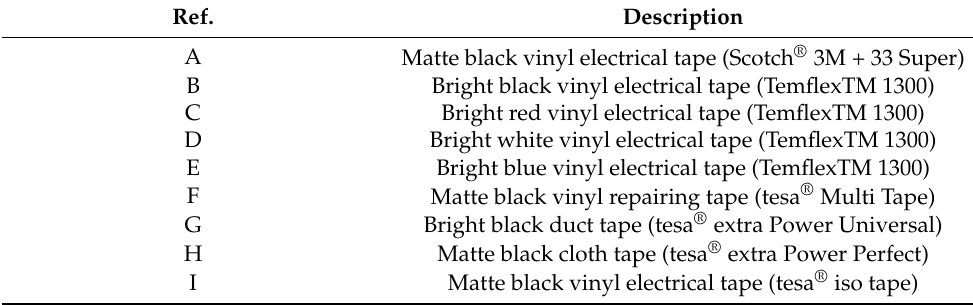
Table 1. Characteristics of the commercial tapes used in task T.Ia. Table 2. Characteristics of the materials used in tasks T.Ib, T.II and T.III [42,44].